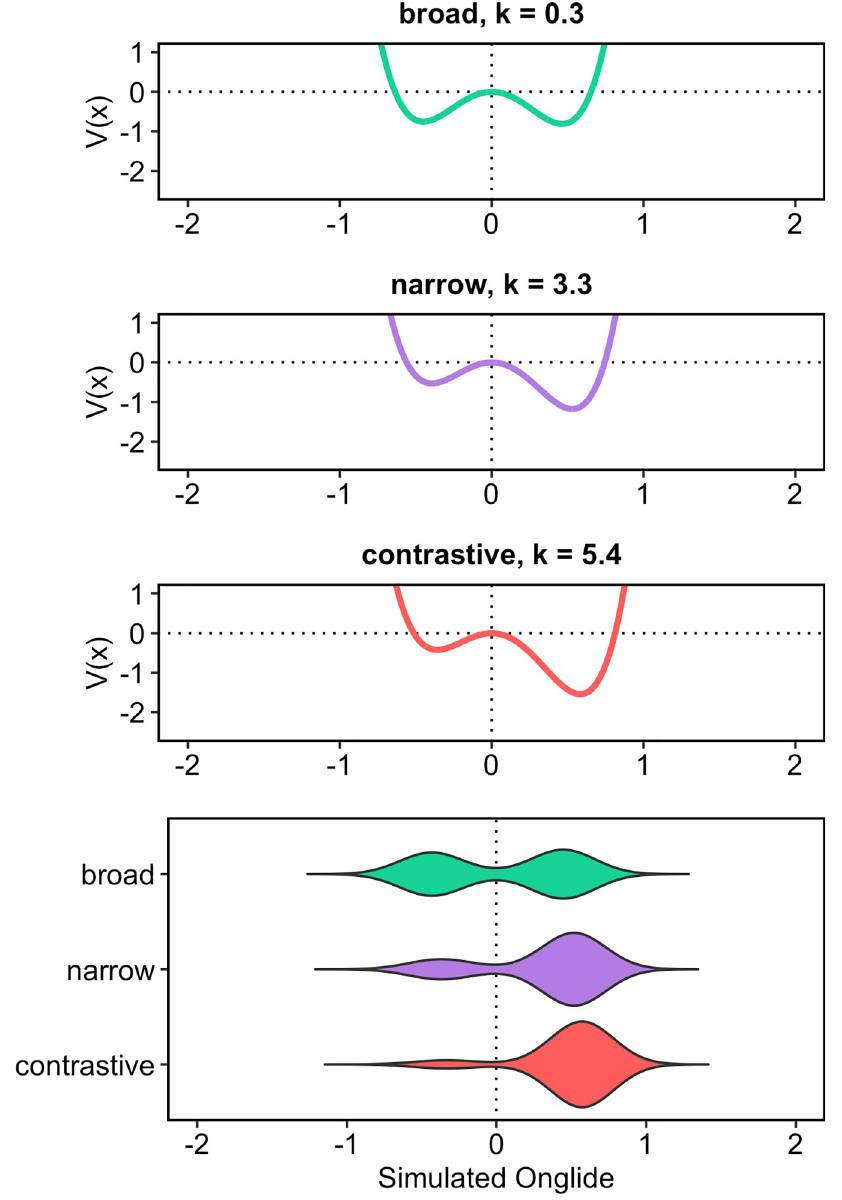
Fig 15. Attractor landscapes and simulated data for broad, narrow and contrastive focus with the best fitting values for the control parameter k. The first three panels from the top show the potentials for the three focus types. The lower panel gives the simulation